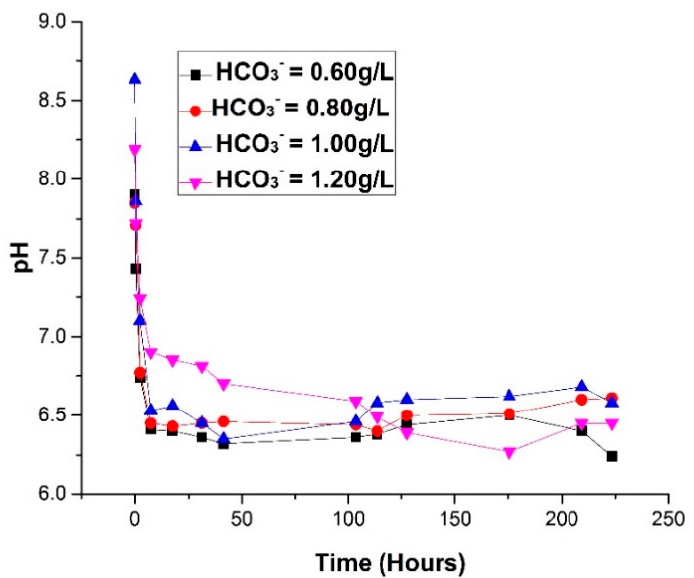
Figure 7. Change in pH measurements in the leaching solution.